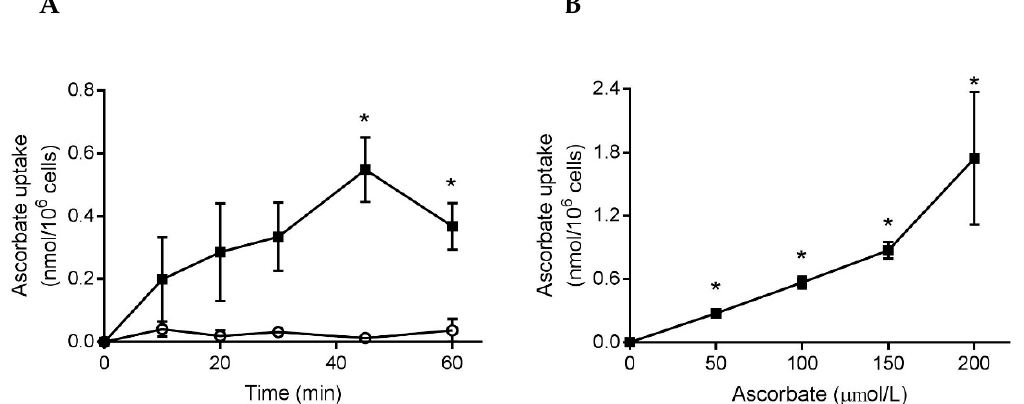
Figure 5. Ascorbate uptake by stimulated neutrophils. ( A ) Cells were incubated with extracellular ascorbate (100 µ mol / L) for the indicated times, in the absence ( ) or presence ( (cid:4) ) of PMA (100 ng / mL). The time zero ascorbate concentration was 0.34 ± 0.134 nmol / 10 6 cells, n = 4. ( B ) Cells were incubated with increasing concentrations of ascorbate for 45 min in the presence of PMA (100 ng / mL). The starting ascorbate concentration was 0.29 ± 0.11 nmol / 10 6 cells, n = 3. The intracellular ascorbate concentration was measured by HPLC. Data represent mean ± SEM, * p < 0.05.